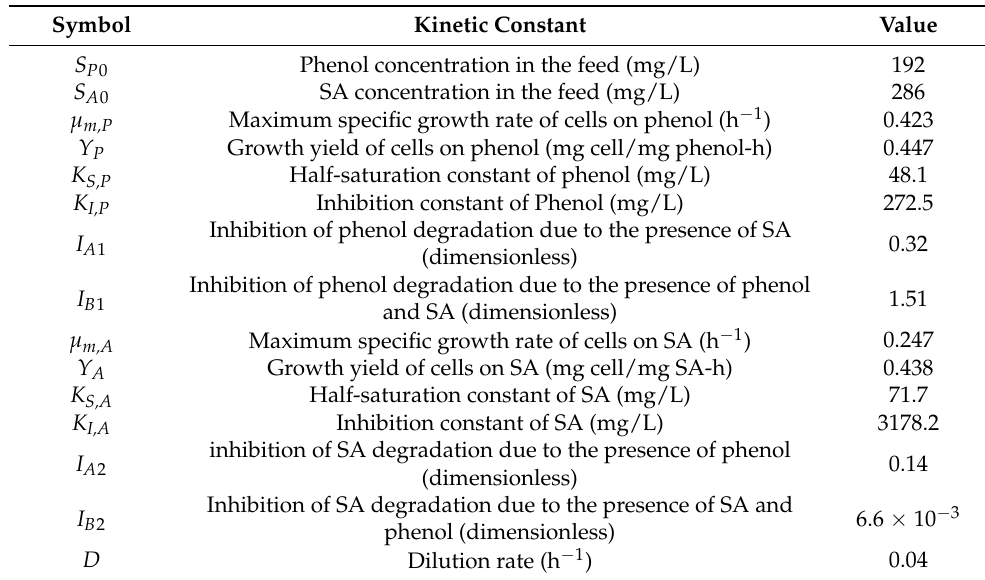
Table 1. Kinetic constants of phenol and SA for the chemostat model